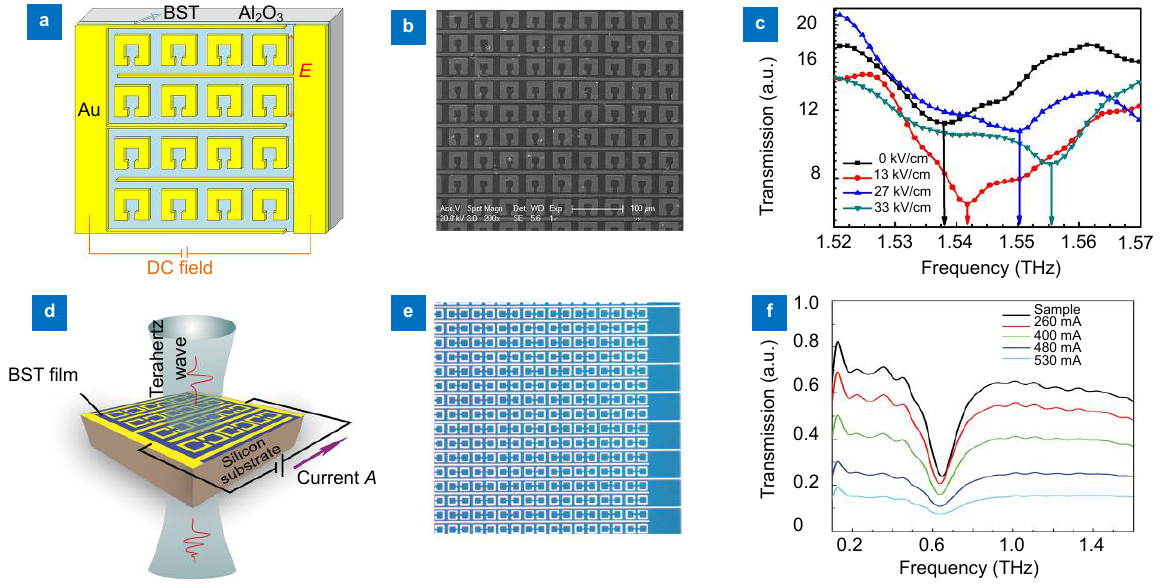
Fig. 8 | Electrical tuning of the ferroelectric material in active metamaterials . ( a ) Schematic view of the SRR unit cell and the IDE patterns. ( b ) SEM image of the SRRs and the IDE patterns. ( c ) Transmission spectra of the metamaterial at various electric fields. ( d ) Schematic illustration of the metamaterial and experimental design. ( e ) Microscopic image of the fabricated BST–silicon hybrid metamaterial. ( f ) Measured transmission amplitude spectra of the BST–silicon hybrid metamaterial at various gate currents. Figure reproduced from: ( a – c ) ref. 51 , AIP Publishing; ( d – f ) ref. 139 , John Wiley and